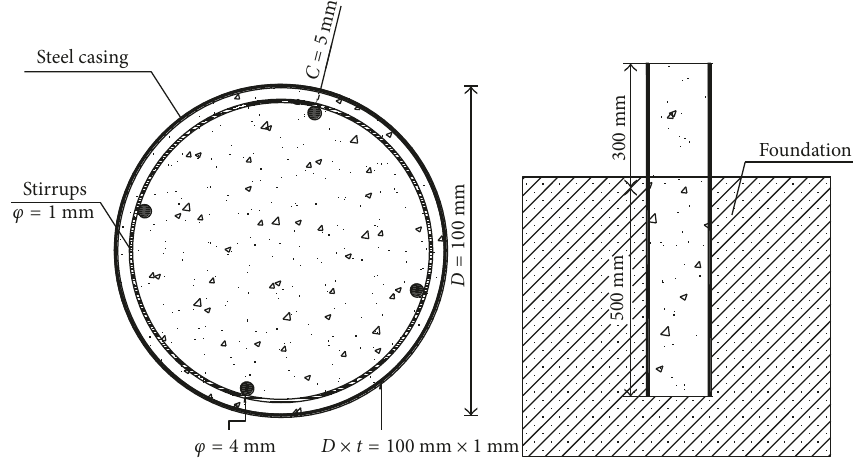
Figure 4: Specimen size. Table 3: Details of the